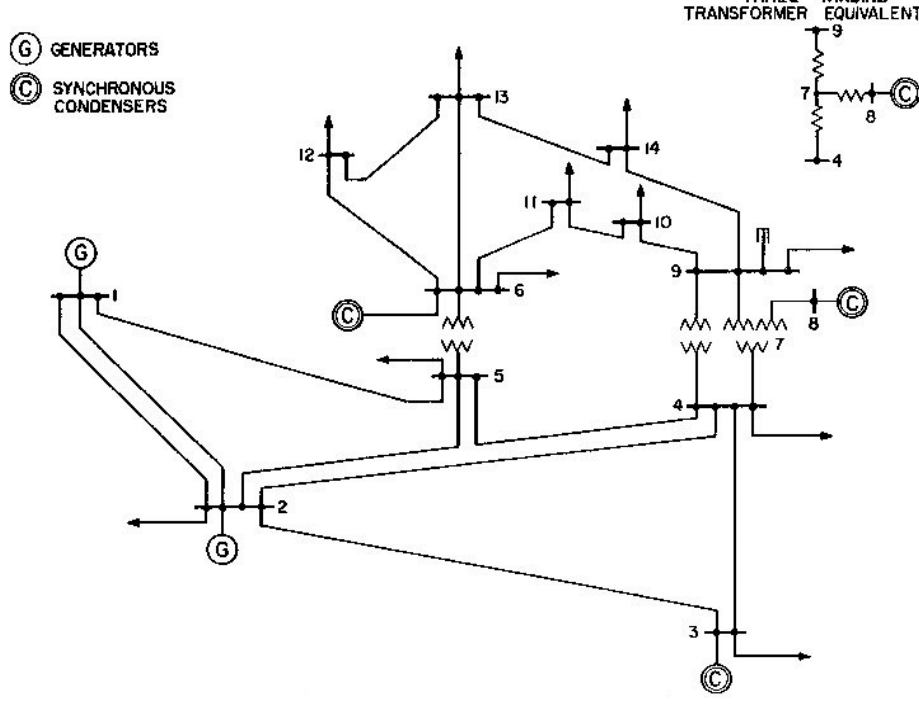
Figure 3. IEEE 14-bus Test System Schematic. Table 2. Contingencies considered and number of lines involved in each contingency.